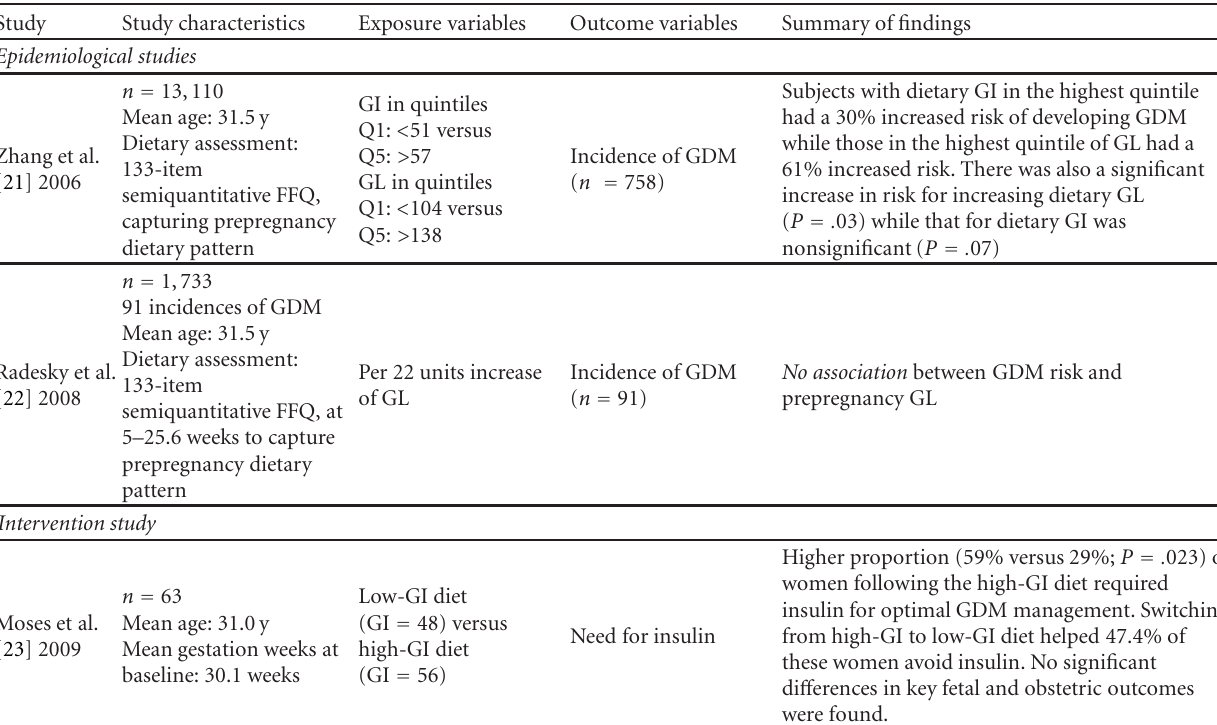
Table 2: Characteristics and outcome measures of studies examining the association between glycemic index/glycemic load and pregnancy outcomes in pregnancies complicated by gestational diabetes